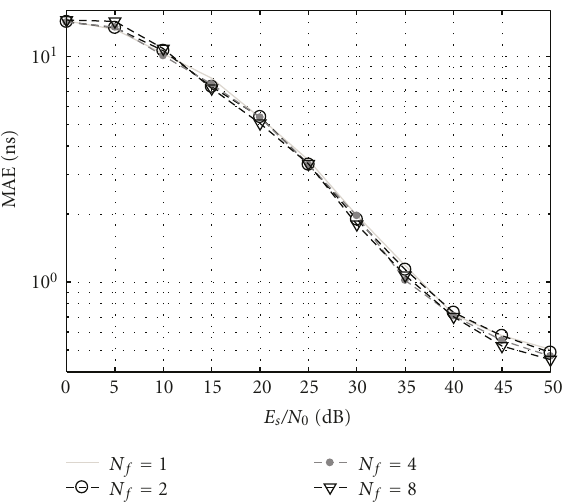
Figure 4: Performance comparison with di ff erent N f in CM1 with T ds = 45 ns, f s = 8GHz, and SCR = − 30dB.